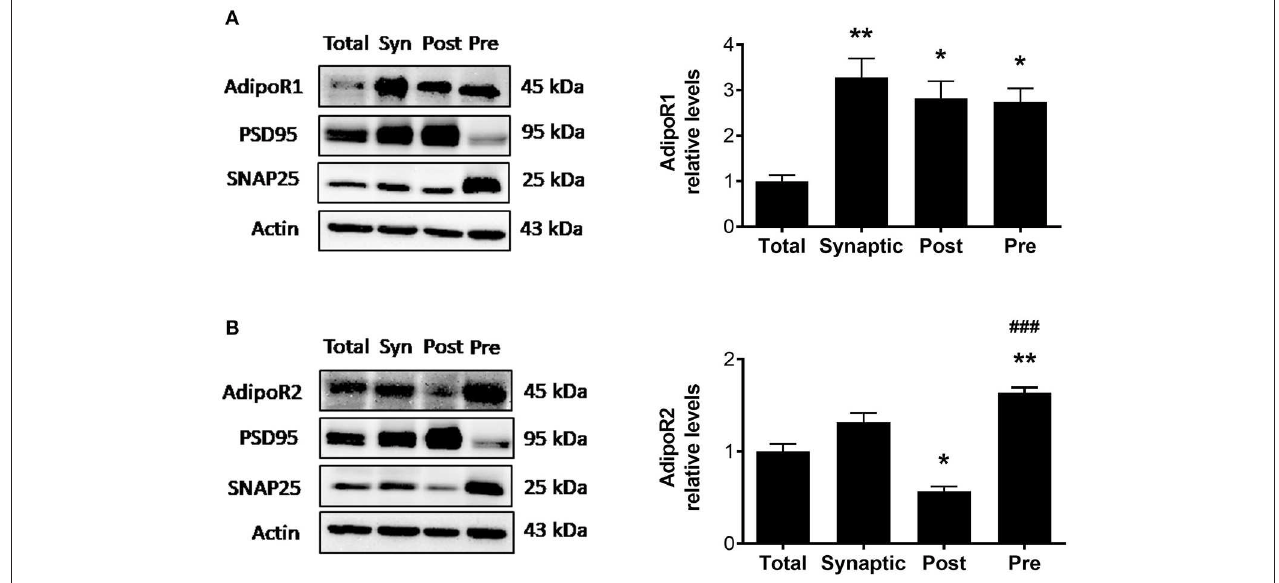
FIGURE 1 | Synaptosomal densities of AdipoR1 and AdipoR2. (A) Representative immunoblot showing AdipoR1 immunoreactivity normalized to beta actin in hippocampal fractions. (B) Representative immunoblot showing AdipoR2 immunoreactivity normalized to beta actin in hippocampal fractions. Hippocampal lysate was divided into total (Total) and synaptosomal (Syn) fractions. The synaptosome was further fractionated into the PSD (Post) and non-PSD (Pre) fractions. Synaptic fractionation efficiency is represented by immunoreactivity of PSD95 and SNAP25 for Post and Pre, respectively. Twenty five micrograms of protein were loaded per lane. Bars represent mean ± SEM from 3 independent experiments, hippocampi from 2 mice were pooled for each experiment (n = 6 mice); *indicates significant difference vs. Total; # indicates significant difference vs. Post; * p < 0.05, ** p < 0.01, ### p < 0.001. Tukey’s post hoc test was used for multiple comparisons.